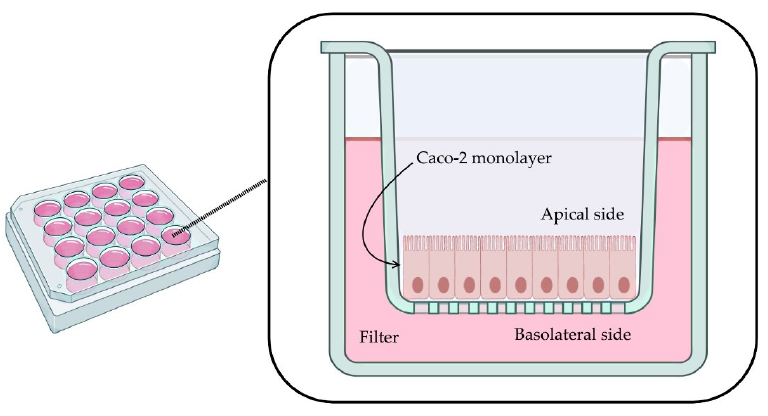
Figure 1. Caco-2 monolayer in permeable filter (illustration created with BioRender [15] for this project).